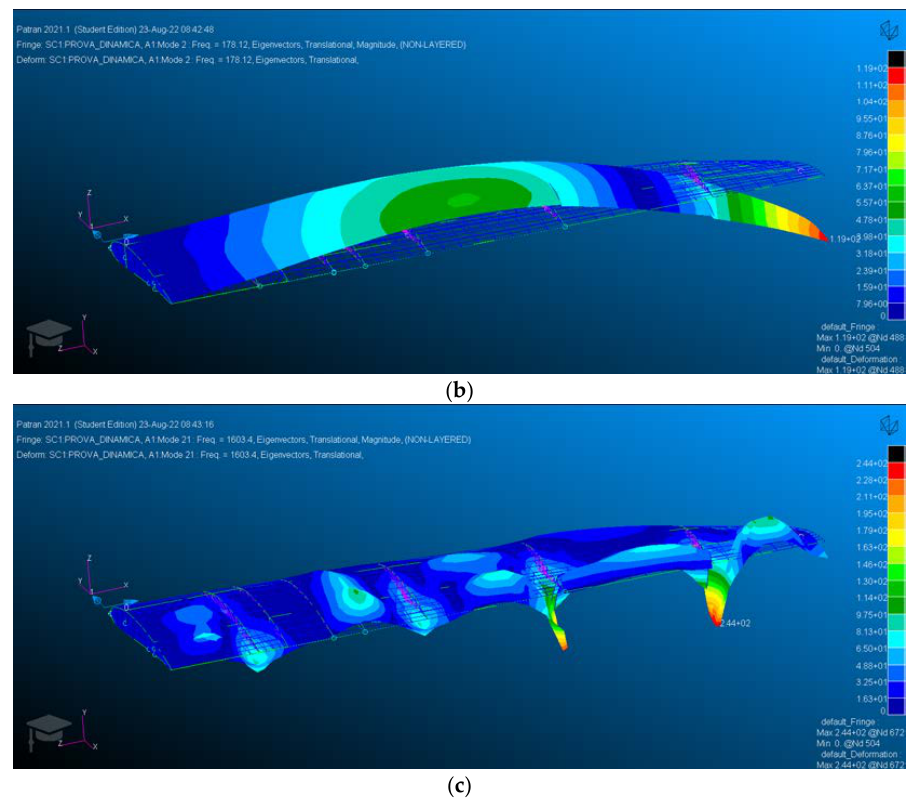
Figure 10. FEM modal analysis, deformed shape, and displacements (magnitude) distribution (mm): ( a ) first mode shape; ( b ) second mode shape; ( c ) residual vector.